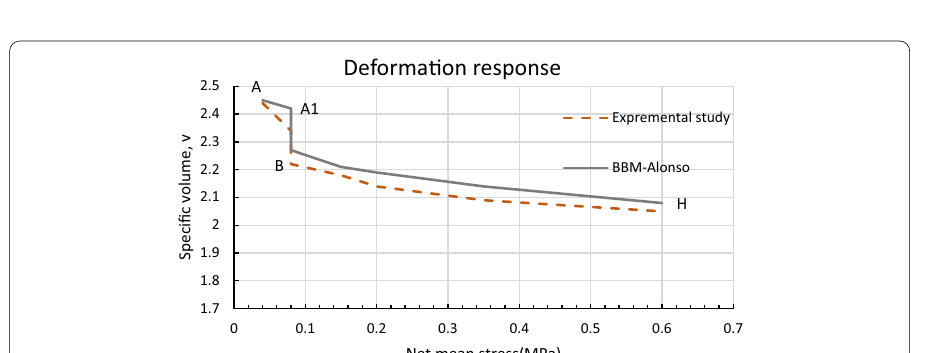
Fig. 11 Comparison between measured and predicted model results for stress path AA 1 BH